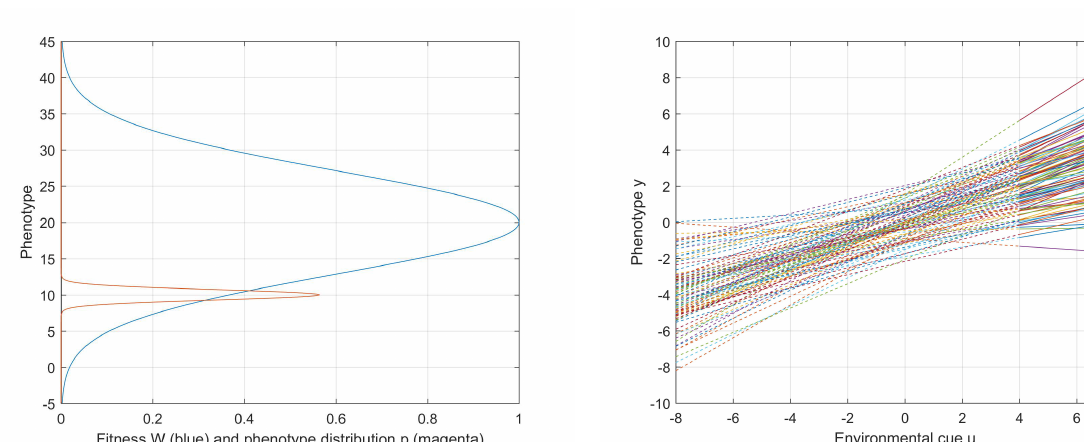
Figure 1: Fitness function W i,t (blue) and phenotype distribution p ( y i,t ) (magenta) in a given en- vironment u and at a given time t , for a case that gives cov ( W i,t , y i,t ) > 0, and thus ¯ y t +1 > ¯ y t . The mean phenotypic value is here ¯ y t = 10, while the phenotypic value that maximizes individual fitness is θ t = 20.